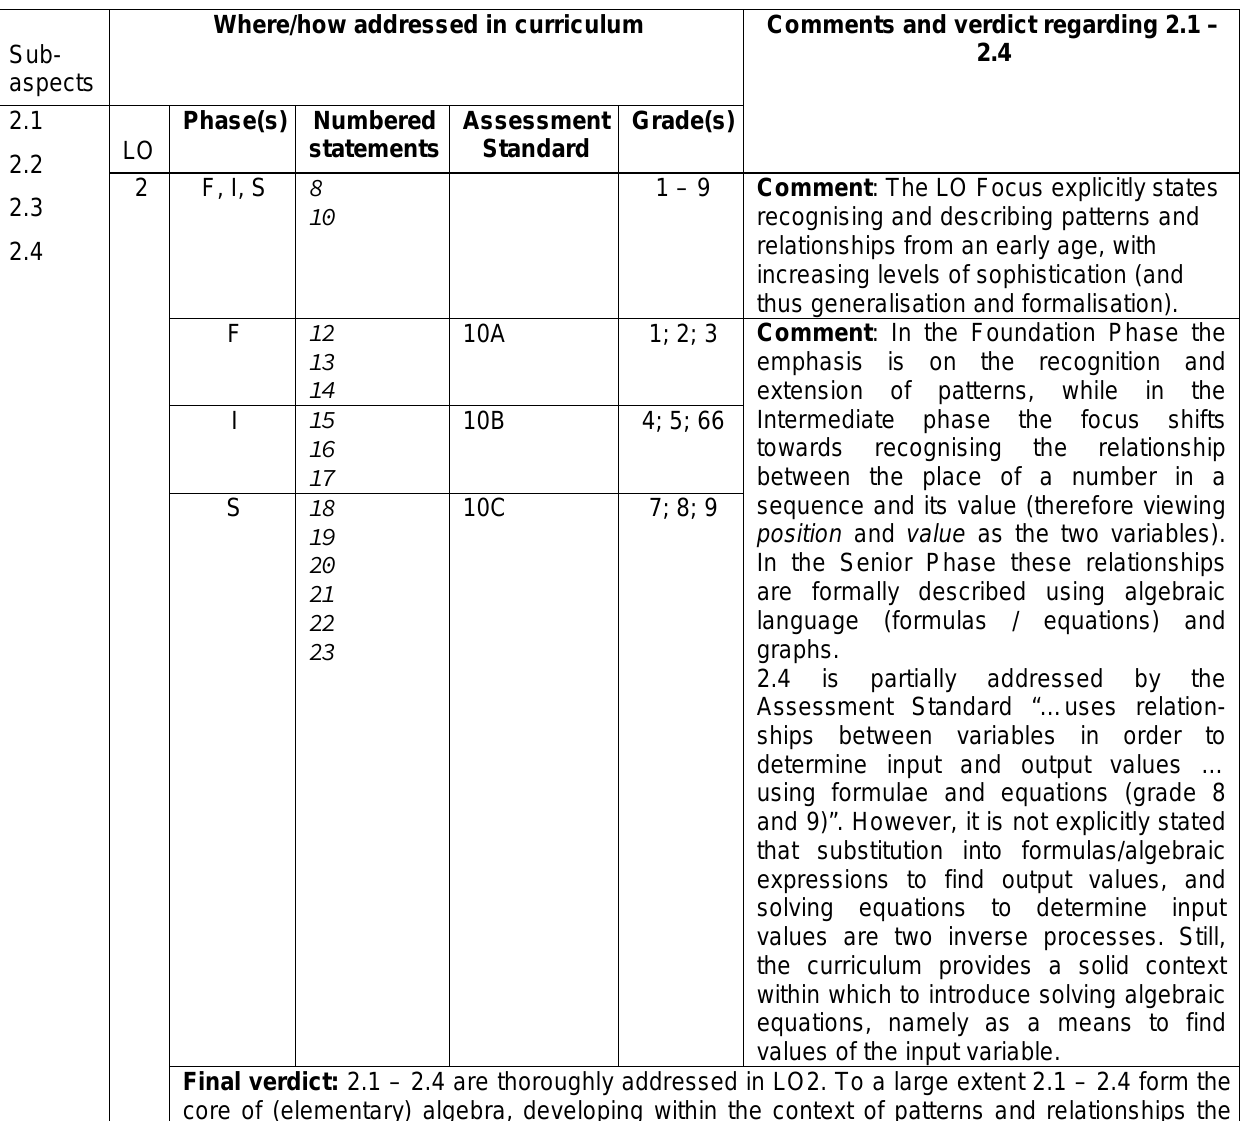
Table 11 Assessment Standards 11A : Building up and breaking down number 11B : Estimates and calculates by selecting and using